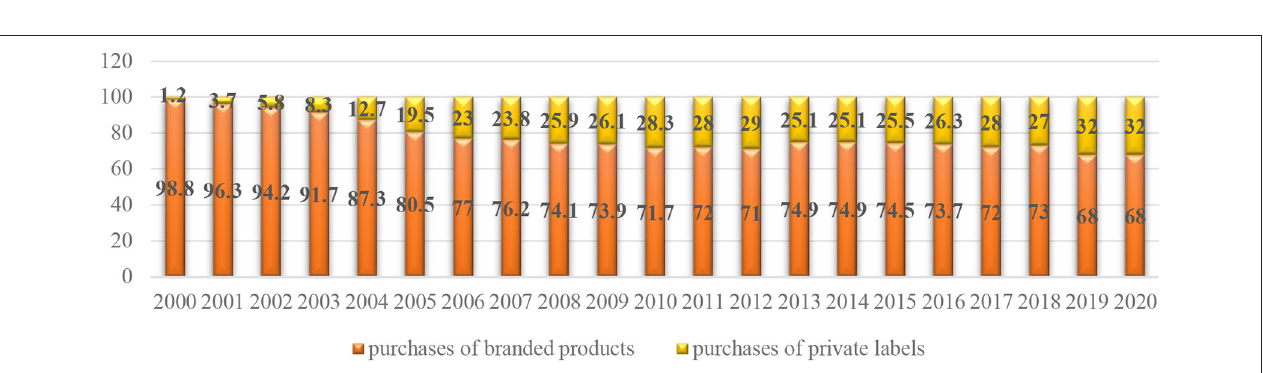
FIGURE 1 | Percentage of private labels in individual product categories in Europe (2013 and 2014, resp. 2016 and 2017). Source: own processing according to available sources.